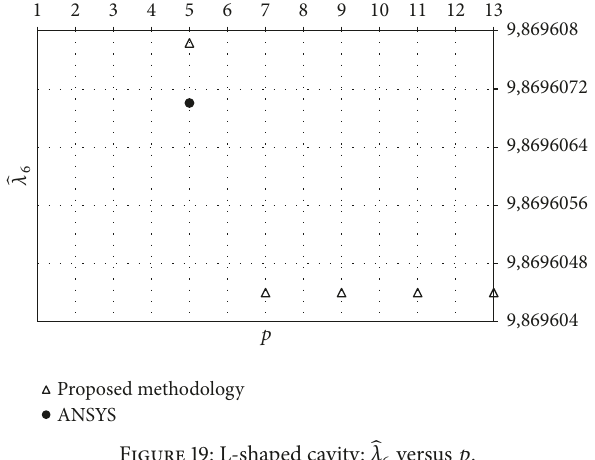
Figure 19: L-shaped cavity: